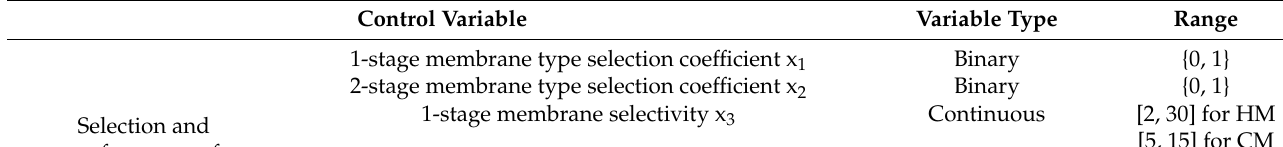
Table 1. The range of control variables. Control